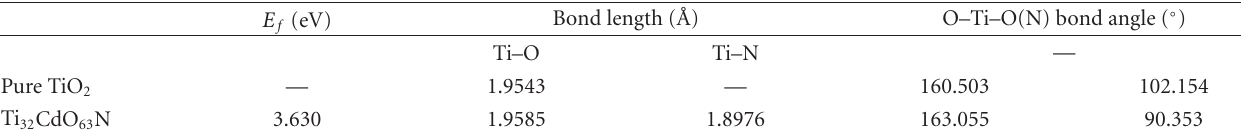
Table 2: Formation energies and optimized structural parameters for pure and N, Cd codoped TiO 2 .